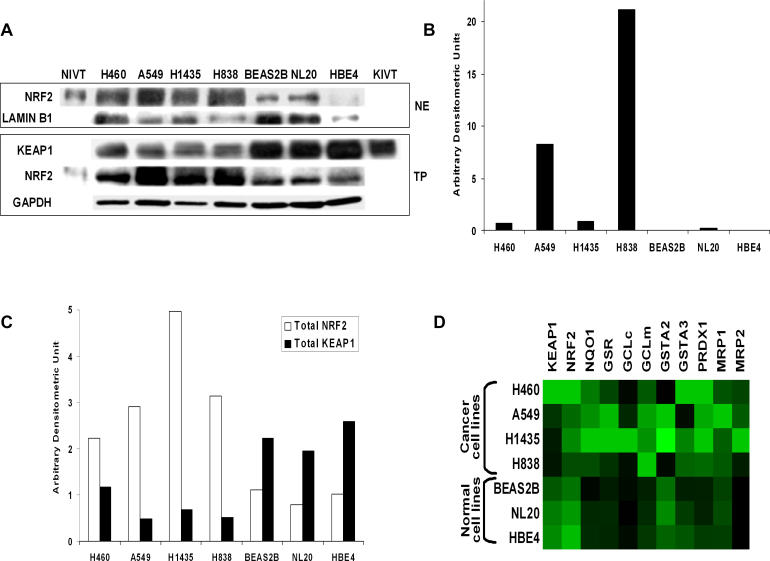
Status of KEAP1 and NRF2 Is Altered in Cancer Cells(A) Immunoblot showing increased nuclear localization of NRF2 in nuclear extracts (NE) from cancer cells. Cancer cells showed lower levels of KEAP1 (~69 kDa) and higher levels of NRF2 (~110 kDa) in total protein lysates (TP). NIVT and KIVT indicate NRF2 and KEAP1 in vitro transcribed/translated product, respectively.(B and C) Quantification of NRF2 and KEAP1 protein in immunoblots. For band densitometry, bands in nuclear extract blot (B) were normalized to Lamin B1, and those in total protein (C) were normalized to GAPDH.(D) Heat map showing relative expression of KEAP1, NRF2, and NRF2-dependent genes by real-time RT-PCR. Raw data for the heat maps are presented in Table S5.